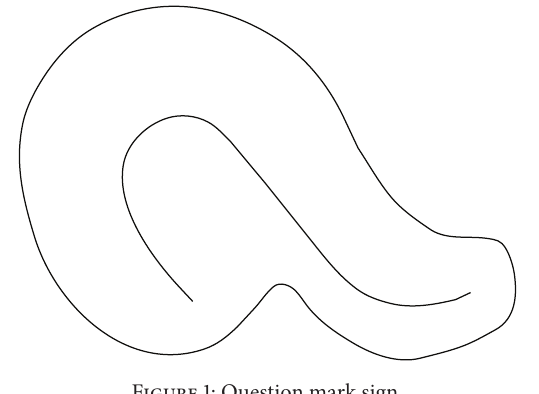
Figure 1: Question mark sign.